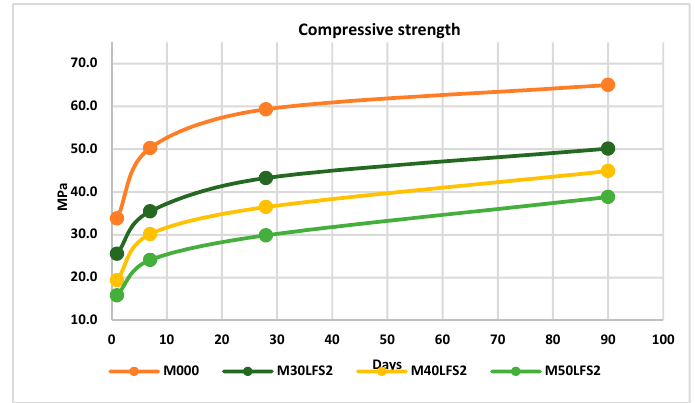
Figure 7. Compressive strength LFS2.